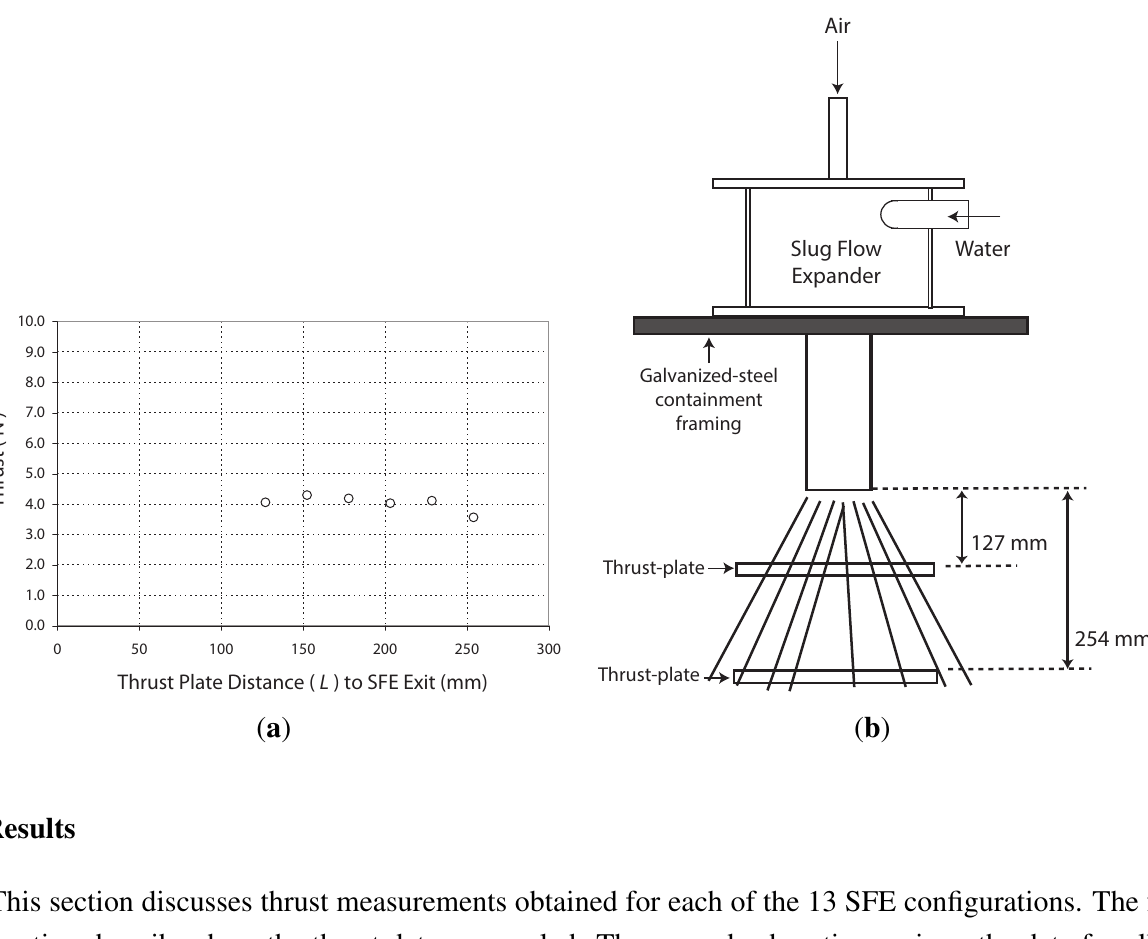
Figure 8. Thrust-plate Distance Study. ( a ) Thrust-plate measurements; ( b ) thrust-plate momentum